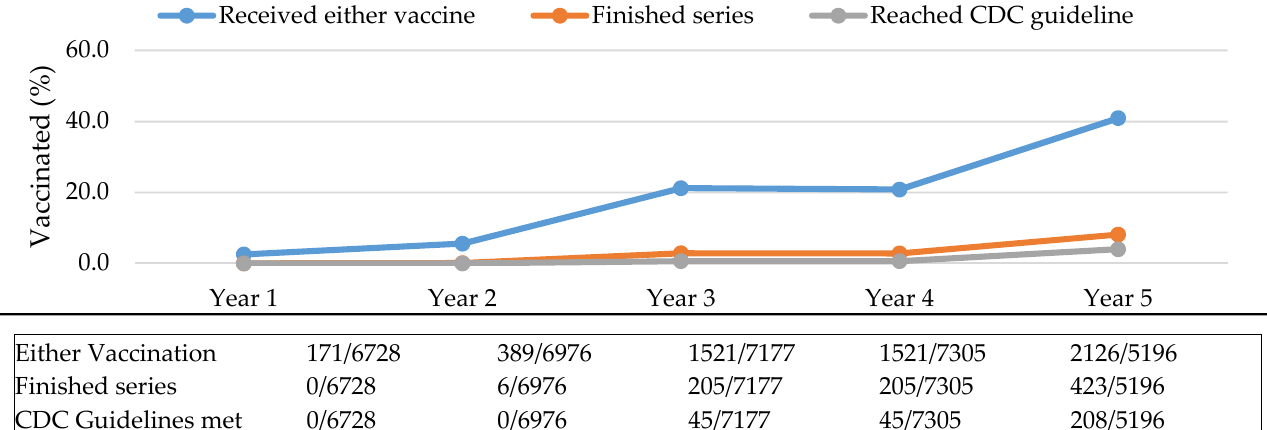
Figure 3. Cumulative proportion of sample population vaccinated. Abbreviations used: CDC: Centers for Disease Control and Prevention.